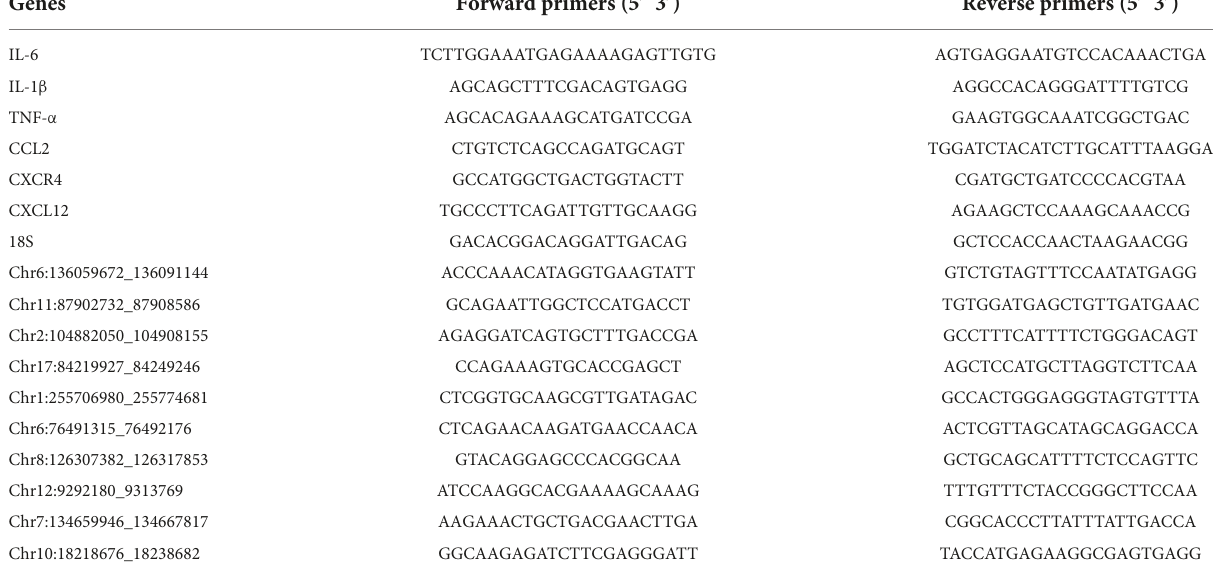
TABLE 1 List of polymerase chain reaction primers for real-time qRT-PCR analysis. Genes Forward primers (5 (cid:48) ˜3 (cid:48) ) Reverse primers (5 (cid:48) ˜3 (cid:48)